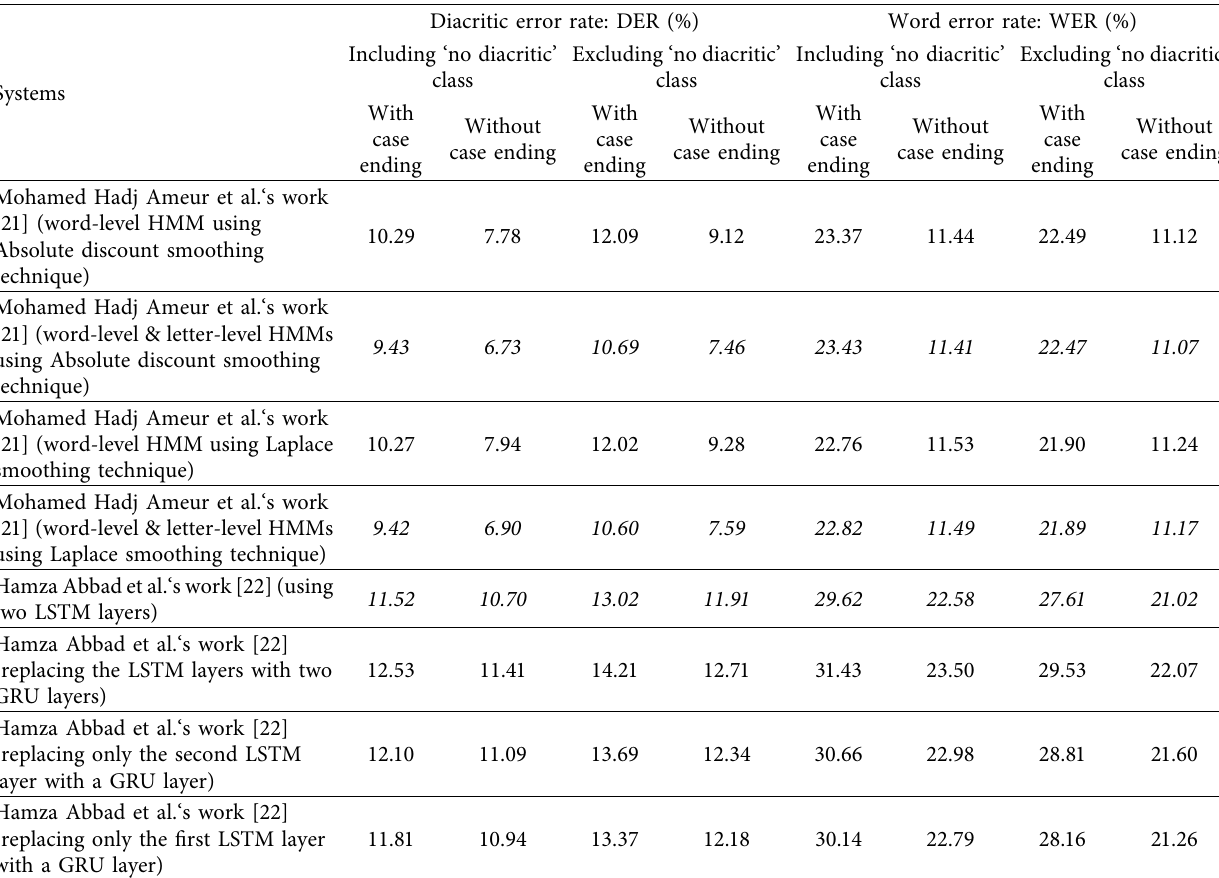
Table 5: Comparison of word error rate (WER) and diacritic error rate